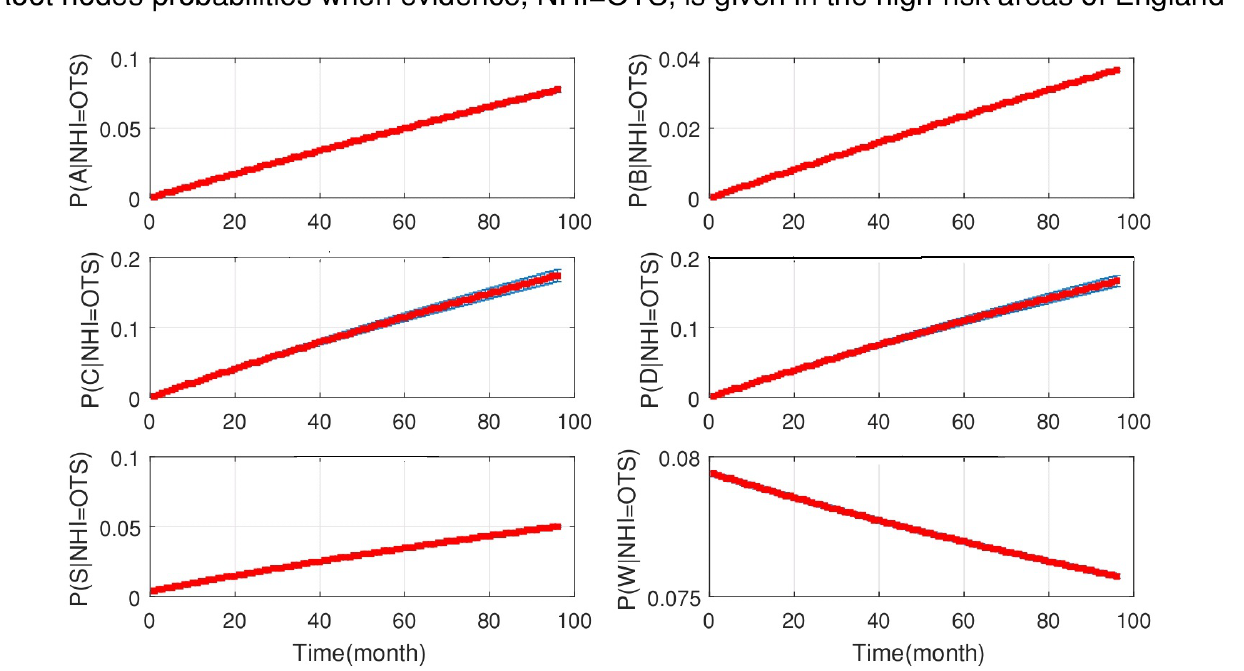
Figure 8. The probabilities of all the root nodes (A is the age of cattle, B is the badger density, C is the manure storage, D is the stock density, S is the silage fed and W is the number of purchased cattle) when new evidence which is officially TB free status suspended (OTS) is added to the network continuously from 2008 to 2015 (bottom-up inference for diagnosis).